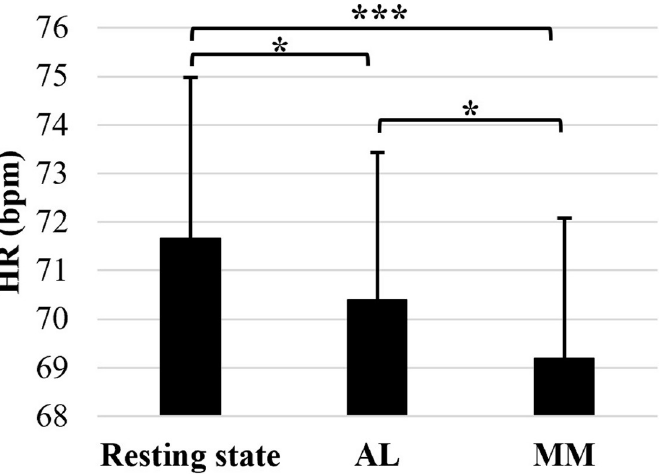
Fig 1. Mean heart rate (HR). Mean HR (in bpm) observed for all participants (meditators and novices combined) during the baseline resting state, the active control (AL) and the meditation (MM) interventions. Error bars represent the normalized 95% confidence interval. � p � 0.05 and ��� p � 0.001.